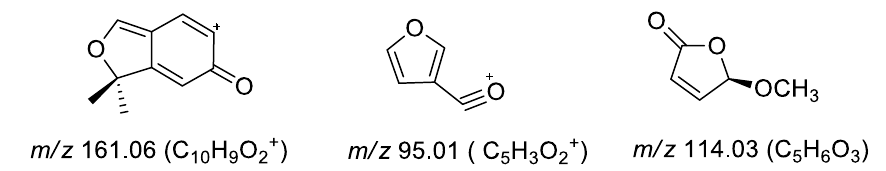
Figure 6. Proposed major fragments of phenolic compounds.